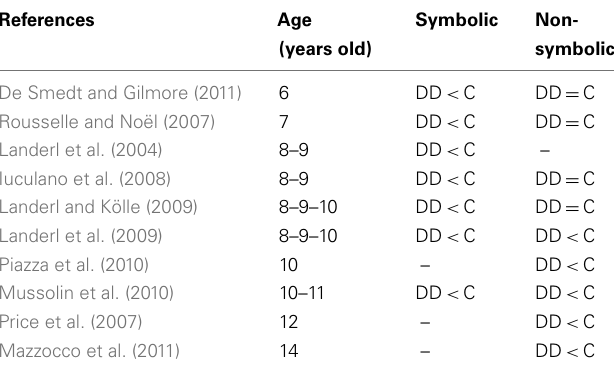
Table 1 | Comparison of the performance of DD and Control children in the symbolic or non-symbolic number